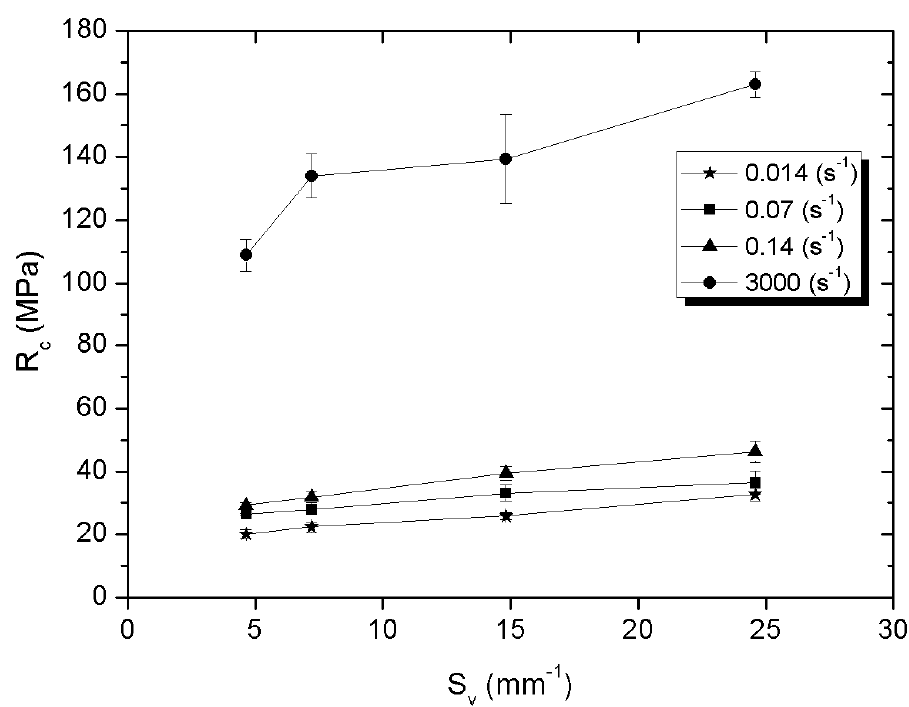
Figure 9. Compressive strength of ceramic-elastomer composites depending on S v parameter for